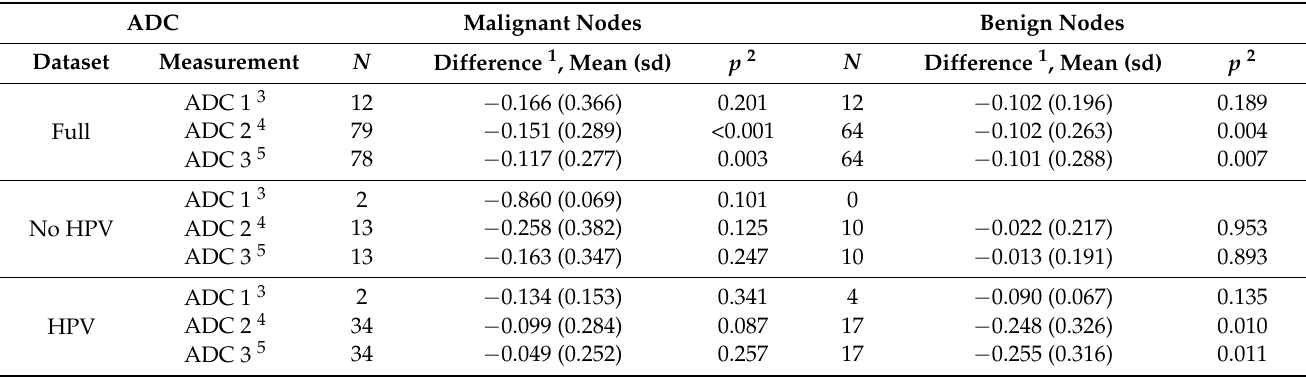
Table 5. Difference in mean ADC values between the PET-negative reference node and PET-positive